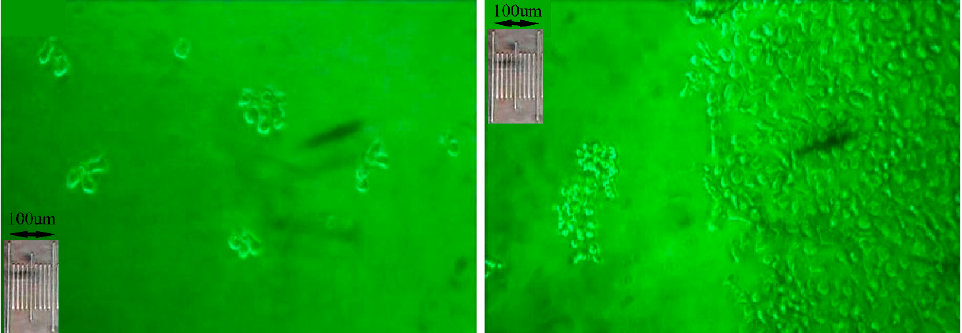
Figure 4 . CCRF-CEM morphology during the experimental setup. Image acquisition was performed with an inverted microscope and a polarized light filter (magnification ×100). The micrometer pre- sented is a Nikon micrometer, type MBM 11100 (stage micrometer type A), of 1mm total length and graduations of 0.01mm (=100 μ m). The micrometer is in the same magnification (×100) as the mi- croscopy image [43].